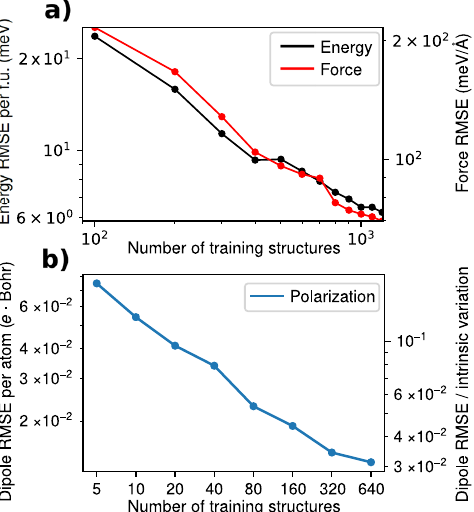
Fig. 11 Learning curves of the ML models. a The GAP model for energies and atomic force components, trained on a total of 1200 training structures with 258 randomly selected structures used as the validation set and b the SA-GPR polarization model, trained on a total of 640 structures with 200 validation structures.